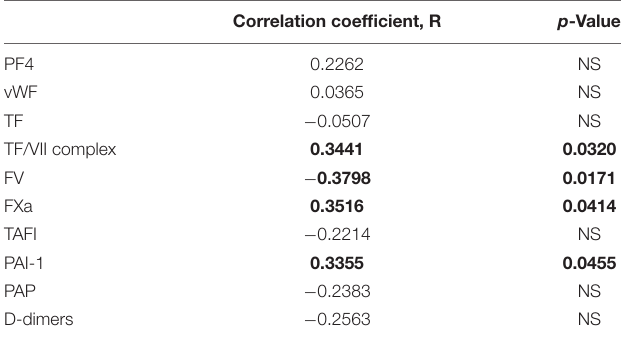
TABLE 6 | Relationships between parameters of hemostasis and concentrations of